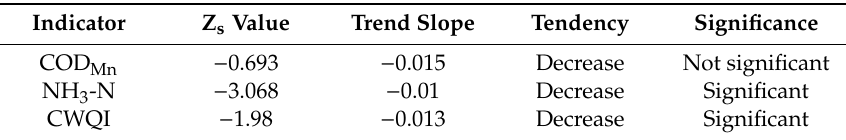
Table 2. Trend analysis of regional annual mean COD Mn , NH 3 -N, and CWQI. Indicator Z s Value Trend